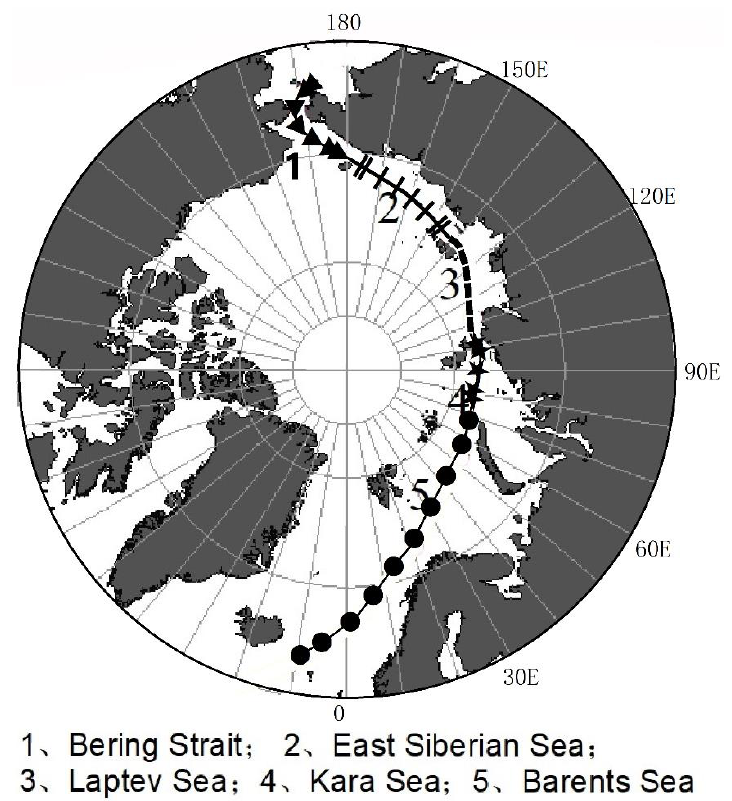
Figure 1. Schematic diagram of the Arctic NEP. Section 1 (triangle) is the Bering Strait, Section 2 (transverse line) is the East Siberian Sea, Section 3 (dotted-line) is the Laptev Sea, Section 4 (pentacle) is the Kara Sea, and Section 5 (circle) is the Barents Sea.